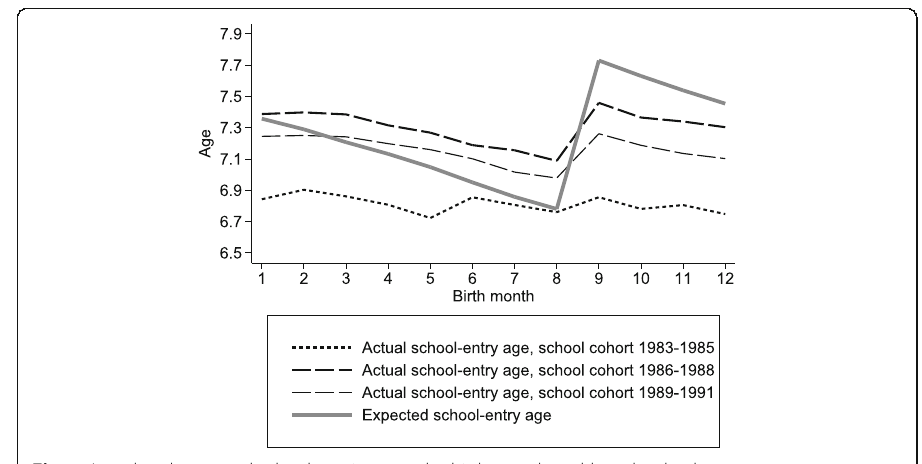
Fig. 4 Actual and expected school starting ages by birth month and by school